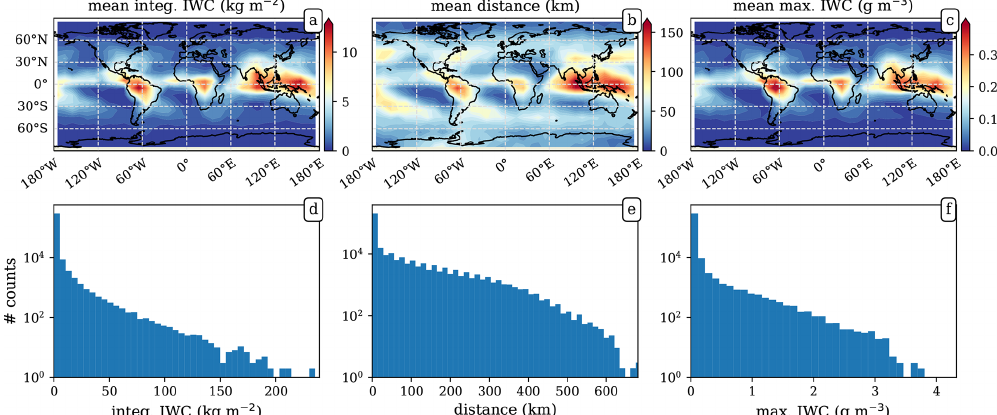
Figure 2. Statistics of the CloudSat-RO database corresponding to the rays whose tangent height is 9km. Panels (a–c) show the mean value climatology for the along-ray integrated IWC, distance (i.e., distance traveled by each ray within the influence of positive IWC), and maximum IWC encountered along the ray, respectively. The used grid is 10 × 10 ◦ . Panels (d–f) correspond to the histograms for the total values for the same integrated IWC, distance, and maximum IWC, as in the first row. The IWC source is the DARDAR retrieval product.